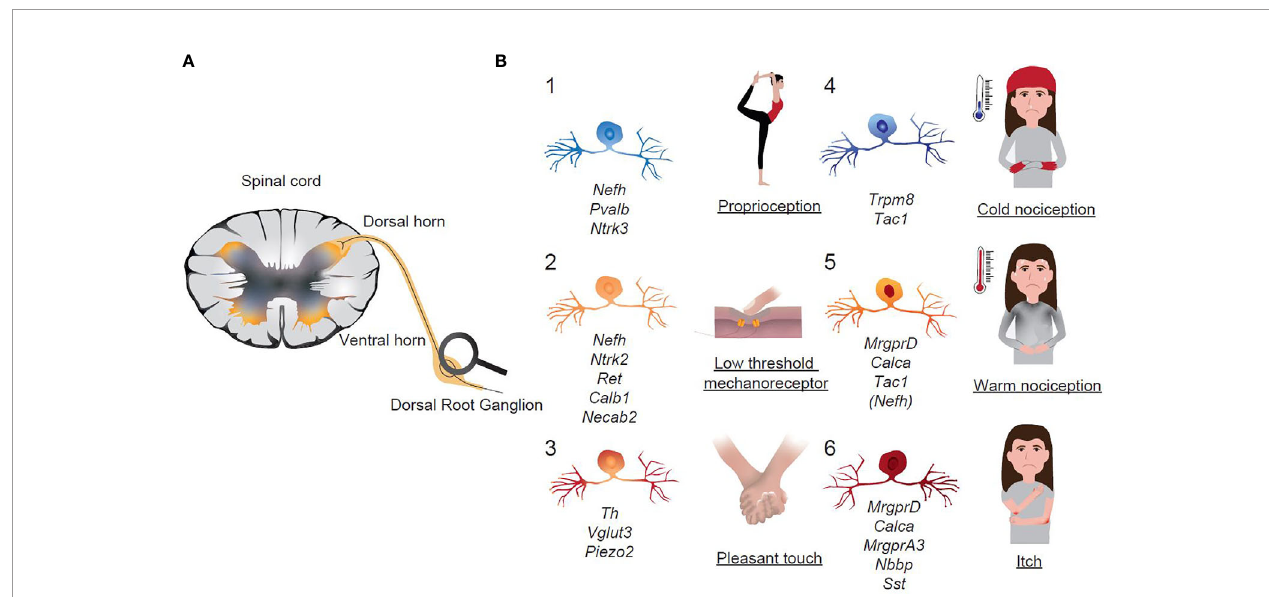
FIGURE 5 | Functional classi fi cation of sensory neurons in Dorsal Root Ganglia. (A) Schematic representation of extrinsic sensory afferent neurons that transmit signals from the periphery to the CNS. (B) Schematic representation of sensory neuronal groups in DRGs with assigned functions. Italics are the key transcripts of the respective neuronal